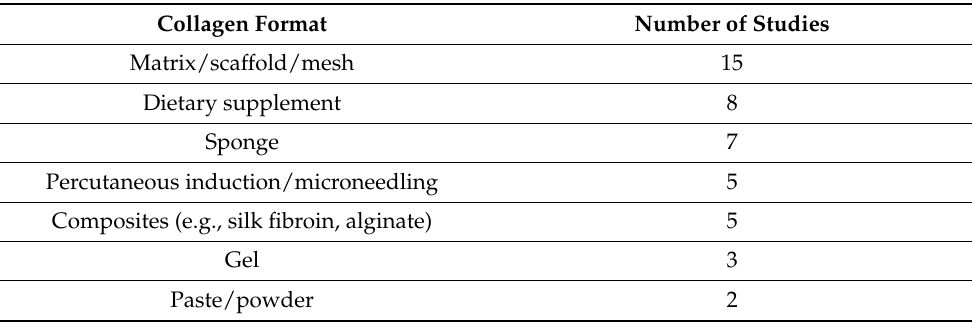
Table 1. Collagen dressing formats for wound healing clinical studies. Collagen Format Number of Studies Matrix/scaffold/mesh 15 Dietary supplement 8 Sponge 7 Percutaneous induction/microneedling 5 Composites (e.g., silk fibroin, alginate) 5 Gel 3 Paste/powder